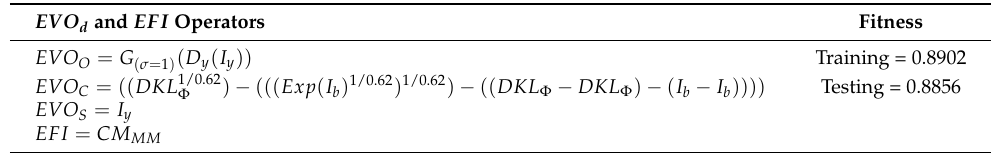
Table 18. Program structure of the operators corresponding to the best solution for the FT database. We select this solution from the seven executions of Table 17. Note that we can simplify the second tree. However, we report the programs as returned by the computer.